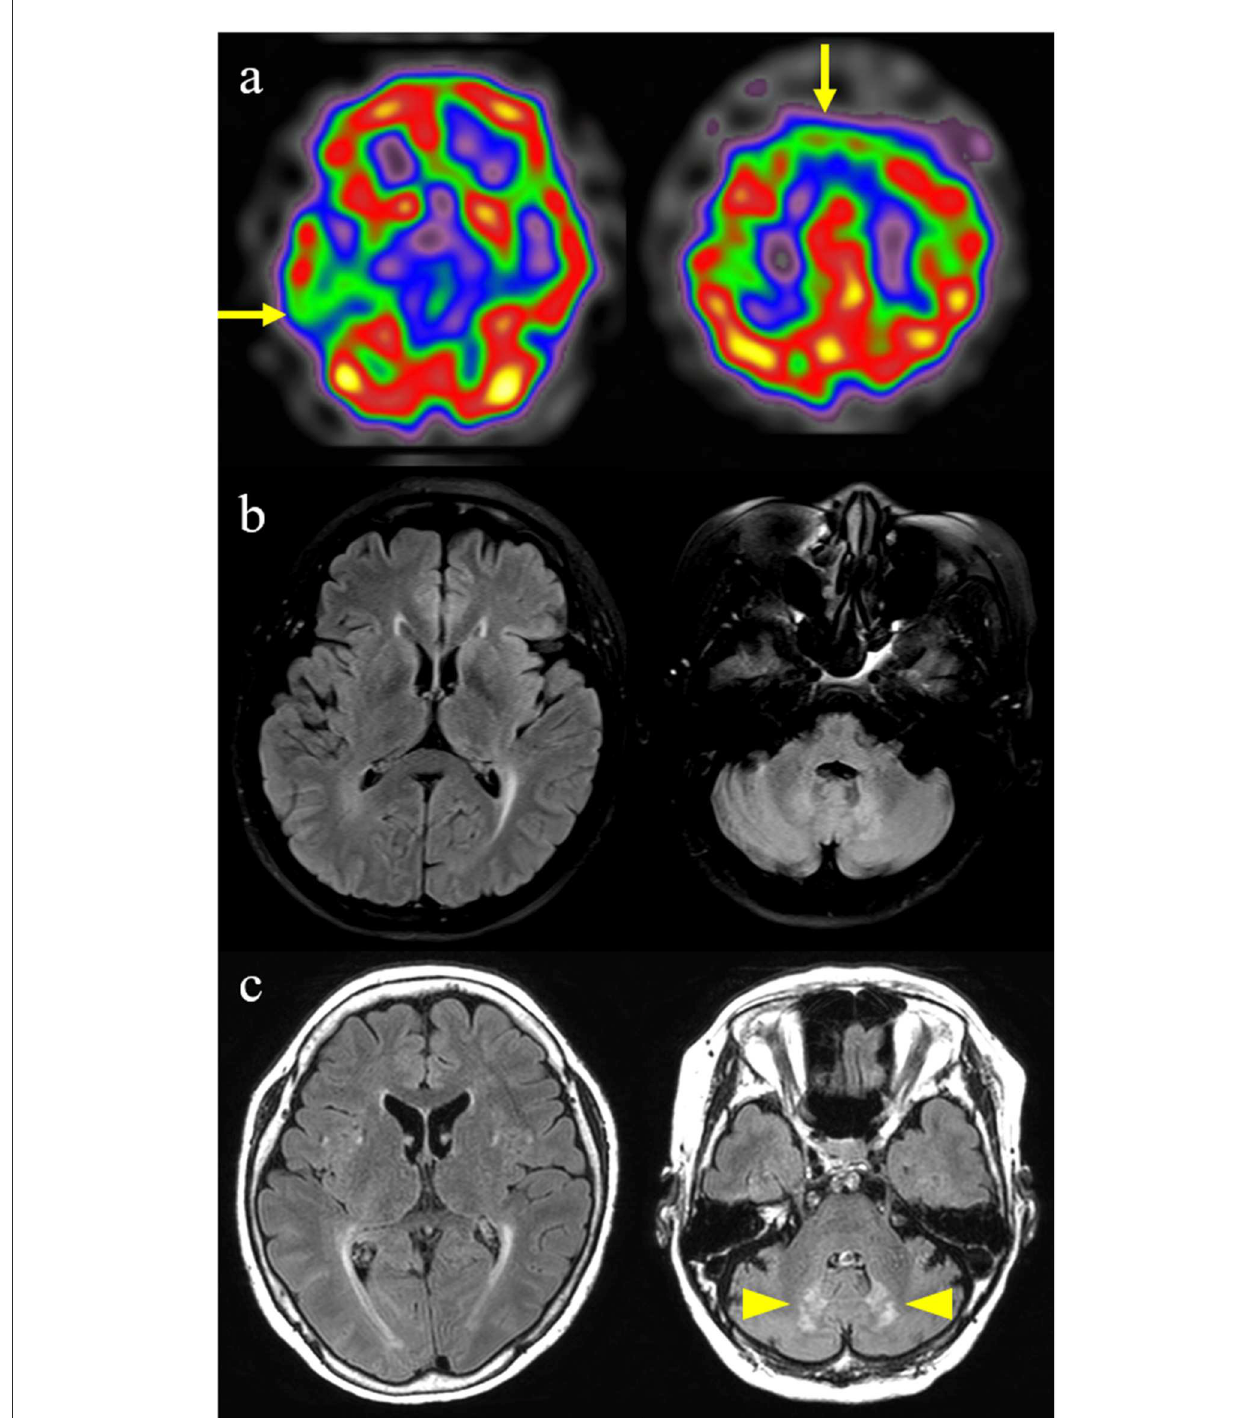
FIGURE2 Brain imaging findings of this patient with cerebrotendinous xanthomatosis. (a) Brain spectroscopy shows hypoperfusion in bilateral frontal and right temporal lobes (arrows). (b) Initial fluid-attenuated inversion recovery image shows slight periventricular white matter changes. (c) Follow-up fluid-attenuated inversion recovery image performed 4 years later shows the progression of periventricular white matter changes and newly developed symmetrical hyperintense lesions in the dentate nucleus of the cerebellum (arrowheads).